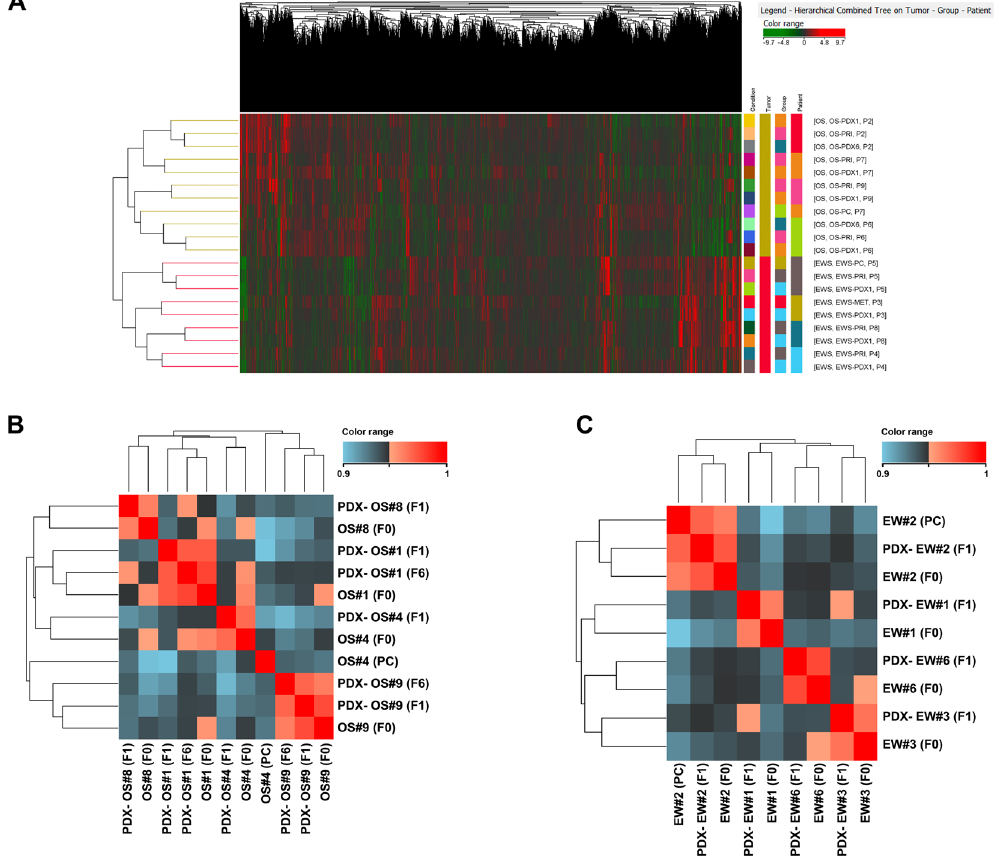
Figure 2. Unsupervised clustering using all (40 K) genes and all specimens ( A ). Correlation between OS ( B ) and EW ( C ) samples calculated using the whole gene expression profile obtained from microarray analysis. Correlation indexes (Pearson’s r) was used to perform the hierarchical clustering of samples (Euclidean distance). Abbreviations: PC, primary in vitro culture; F0, patient’s specimen; F1, PDX at first in vivo passage; F6, PDX at sixth in vivo